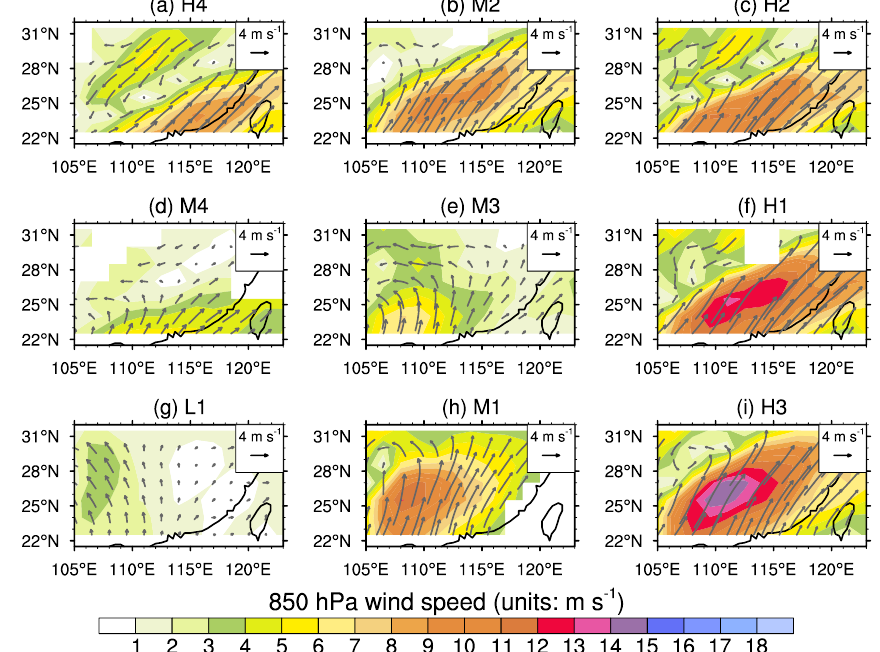
Figure 8. ( a – i ) Composite means of winds (vectors; units: m s − 1 ) at 850hPa and wind speeds (shading; units: m s − 1 ) at 850 hPa for the nine regimes during AMJ 1979–2015. For the wind speeds, only composite means that pass the 95% confidence level based on two-sided Student’s t test against the complementary set of samples are plotted. The winds are plotted if only winds are significant in one direction (zonal or